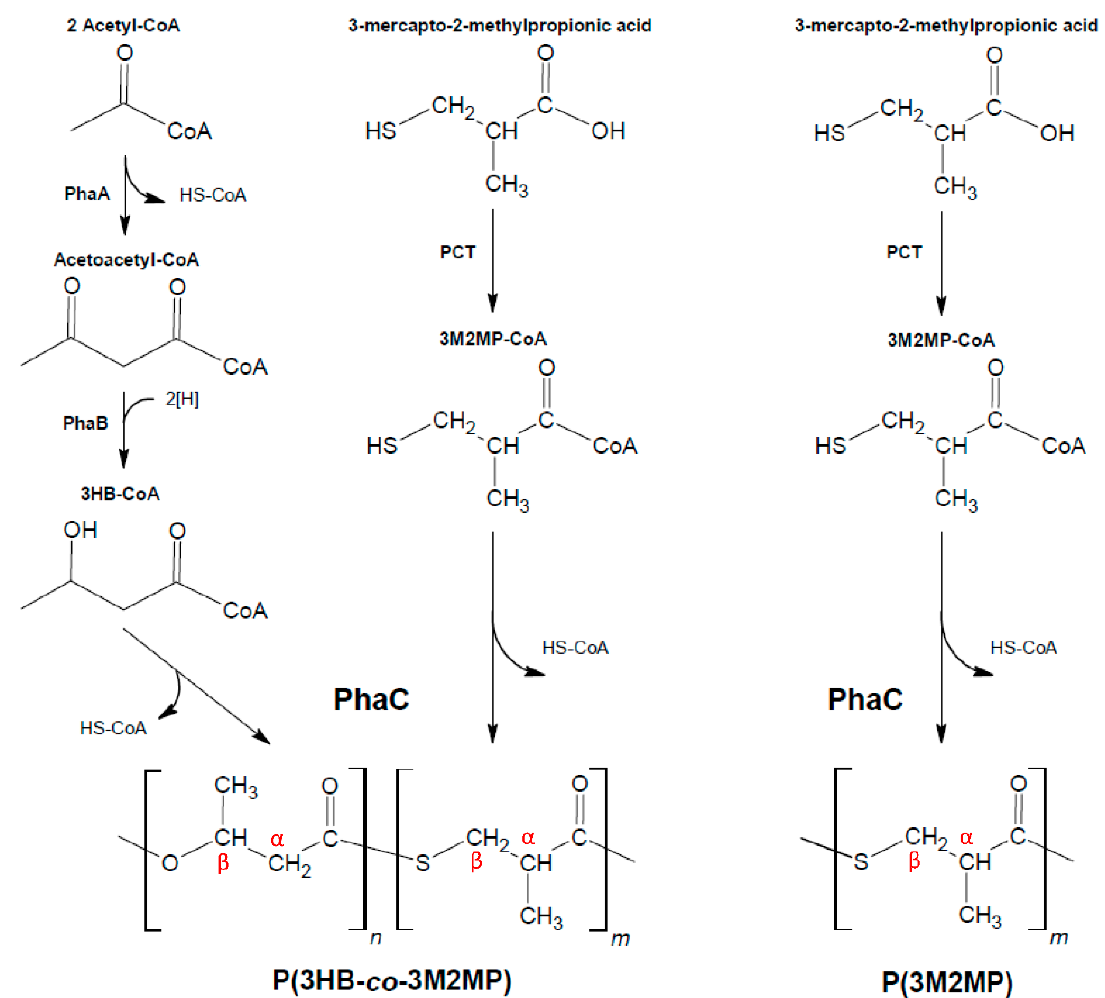
Figure 1. P(3HB- co -3M2MP) and P(3M2MP) biosynthetic pathway. 2.2. P(3HB-co-3M2MP) and P(3M2MP) Biosynthesis, Harvest, and Polymer Content For copolymer production, recombinant E. coli LSBJ was pre-cultivated for 18 h at 30 °C with reciprocal shaking at 160 rpm in a 50 mL flask containing 20 mL of lysogeny broth (LB) medium (i.e., 10 g NaCl, 10 g tryptone, and 5 g bacto-yeast extract per liter of distilled water) with 50 mg/L kanamycin and 50 mg/L carbenicillin. Thereafter, 10 mL/L of pre- culture was inoculated into 500 mL shake flasks containing approximately 100 mL of M9- modified medium (17.1 g/L Na 2 HPO 4 ∙12H 2 O, 3 g/L KH 2 PO 4 , 2.5 g/L bacto-yeast extract, 0.5 g/L NaCl) containing 2 mL/L of 1 M MgSO 4 ∙7H 2 O, 0.1 mL/L of 1 M CaCl 2 , 50 mg/L